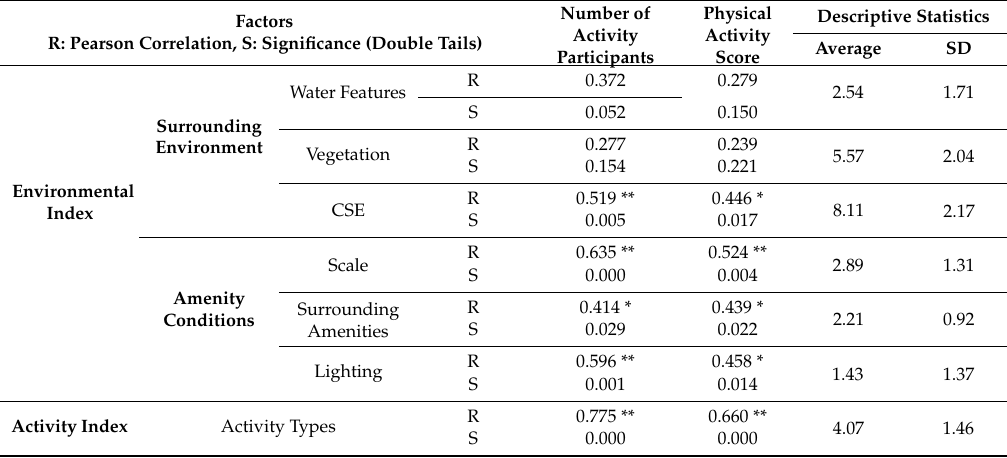
Table 5. Correlation between factors and number of activity participants and physical activity score. Factors R: Pearson Correlation, S: Significance (Double